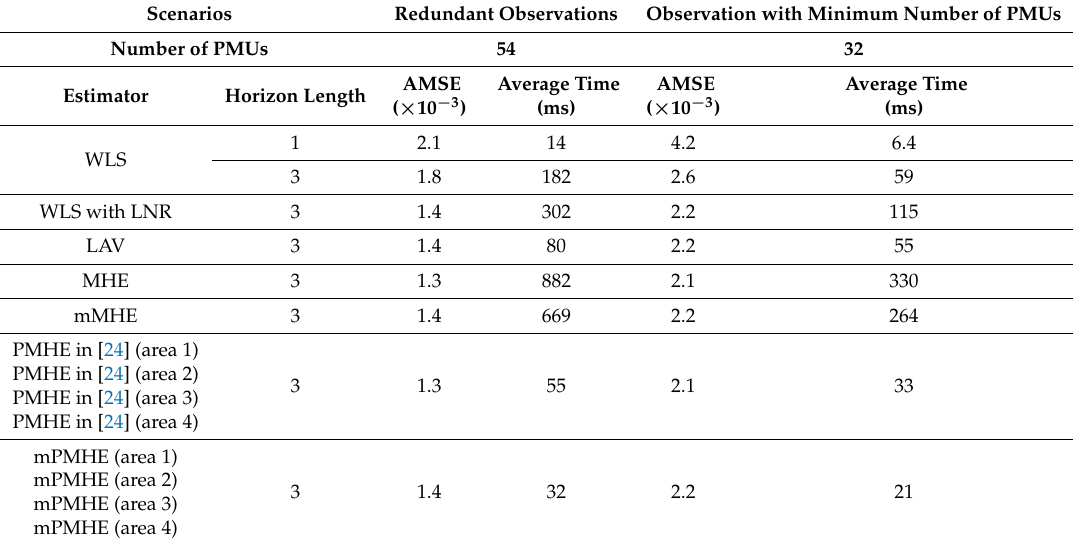
Figure 14. The Mean Square Error (MSE) of WLS(1) (the horizon length of measurements is 1), MHE, mMHE, PMHE and mPMHE with constraints in the IEEE 118-bus system installed with minimum number of PMUs. Table 4. The Average of Mean Square Error (AMSE) and average computation time (per step) with different estimators in the IEEE 118-bus system under two